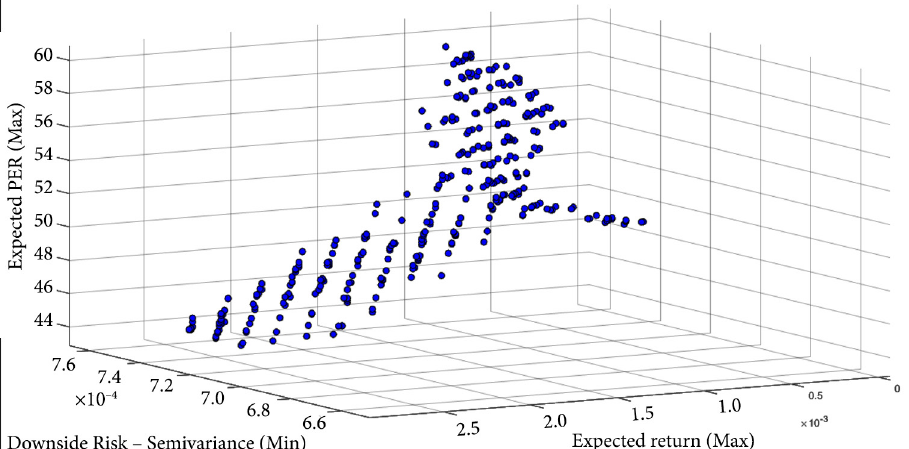
Figure 3. Approximations of the Pareto optimal front of the multiobjective credibilistic mean-semivariance-P/E portfolio se-lection